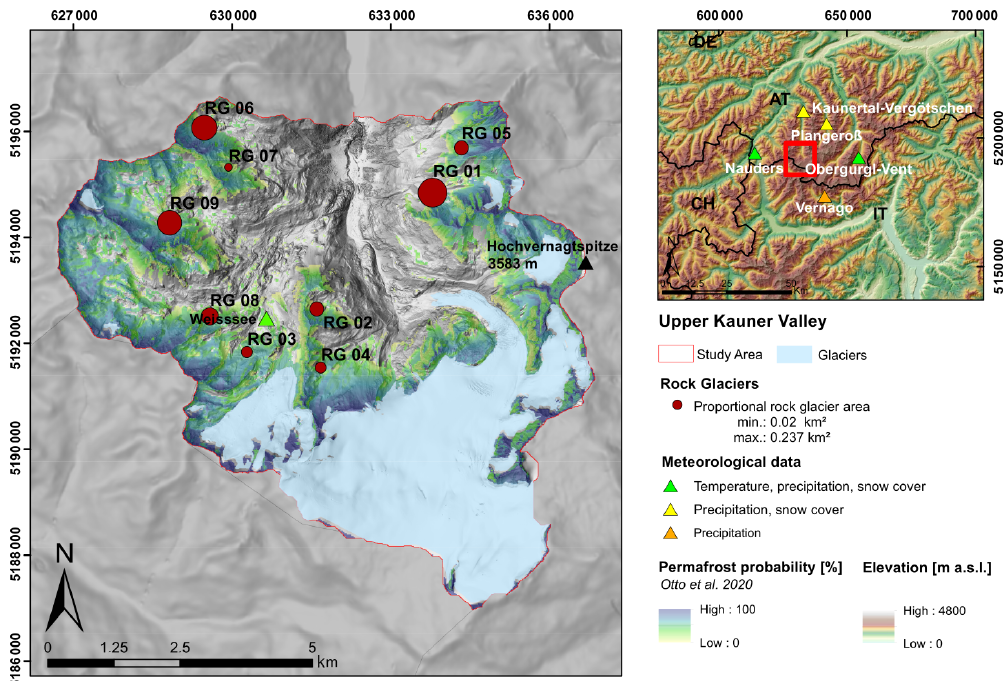
Figure 1. Location and relative size of the investigated rock glaciers and location of the analysed meteorological stations. The stations Obergurgl and Obergurgl-Vent are marked as one station. The coordinate system used is ETRS89/UTM zone 32N EPSG:25832 with the unit metre. The background was created using Copernicus data and information funded by the European Union – EU-DEM layers (https: //land.copernicus.eu/imagery-in-situ/eu-dem, last access: 1 November 2021).